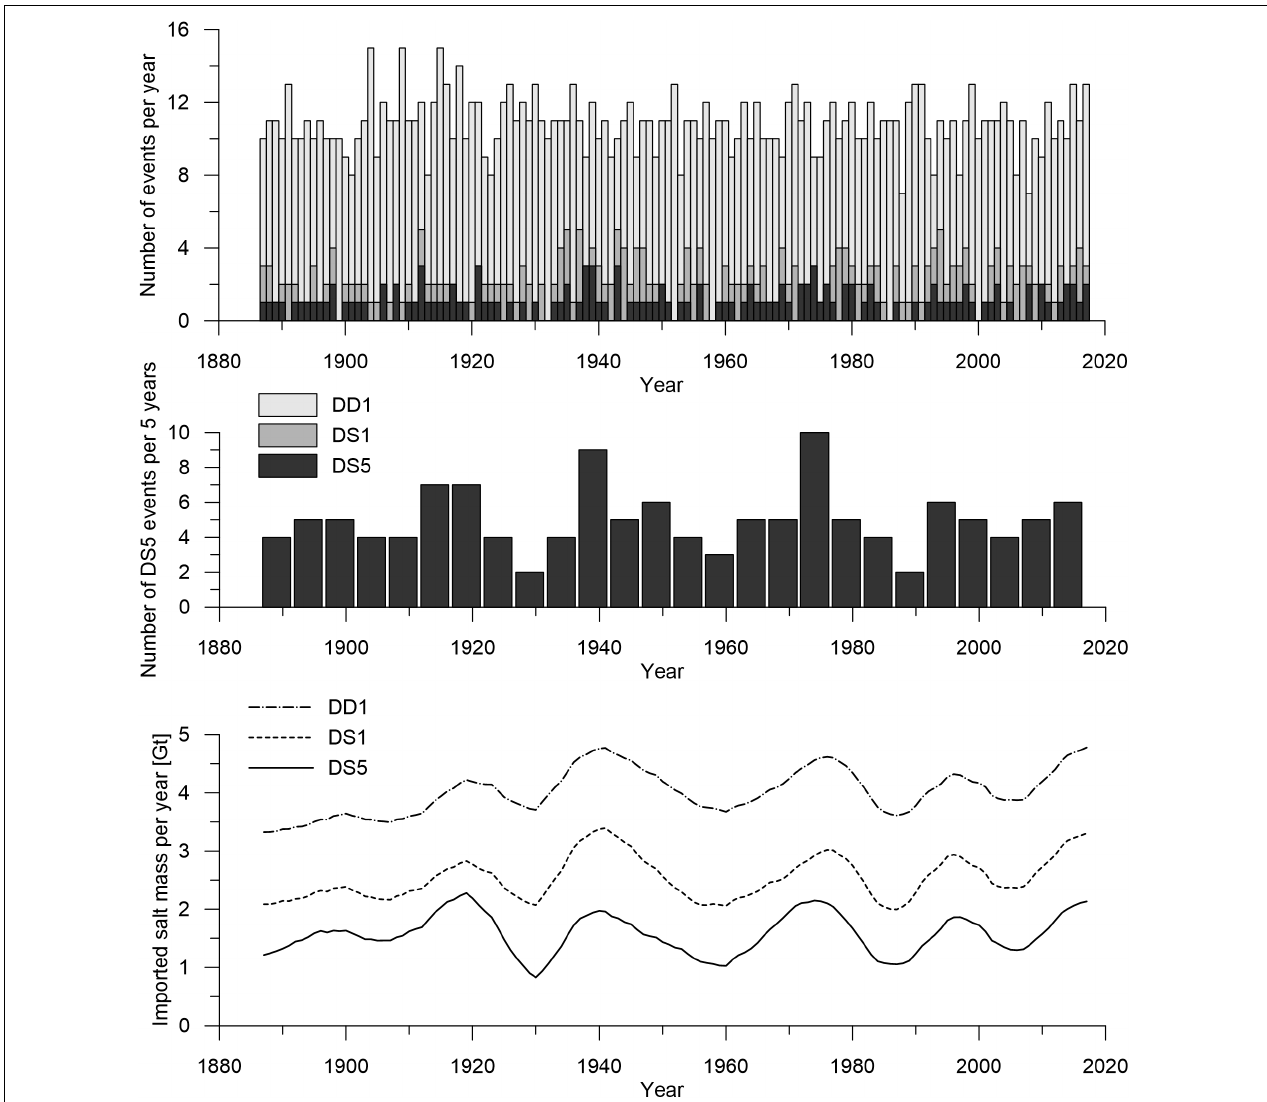
FIGURE 3 | Number of barotropic inflow events per year in the subsets DD1, DS1, and DS5 (top) . Number of barotropic inflow events per 5 year period in subset DS5 (middle) and the 11 year low pass filtered time series of salt mass annually imported by the inflow events of the subsets DD1, DS1, and DS5 (bottom)